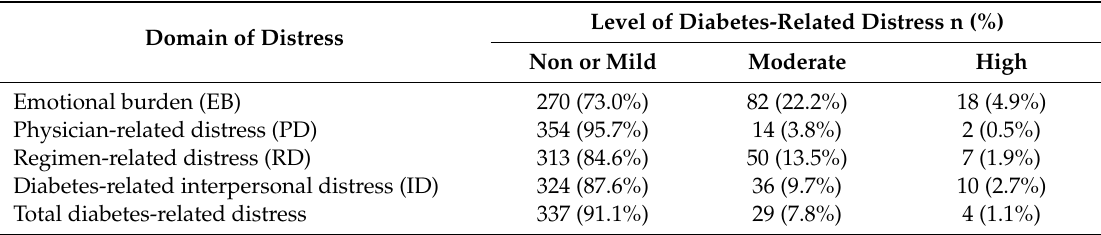
Table 2. Diabetes-related Distress of respondents (n = 370) by Diabetes Distress Scale (DDS)-17 level.